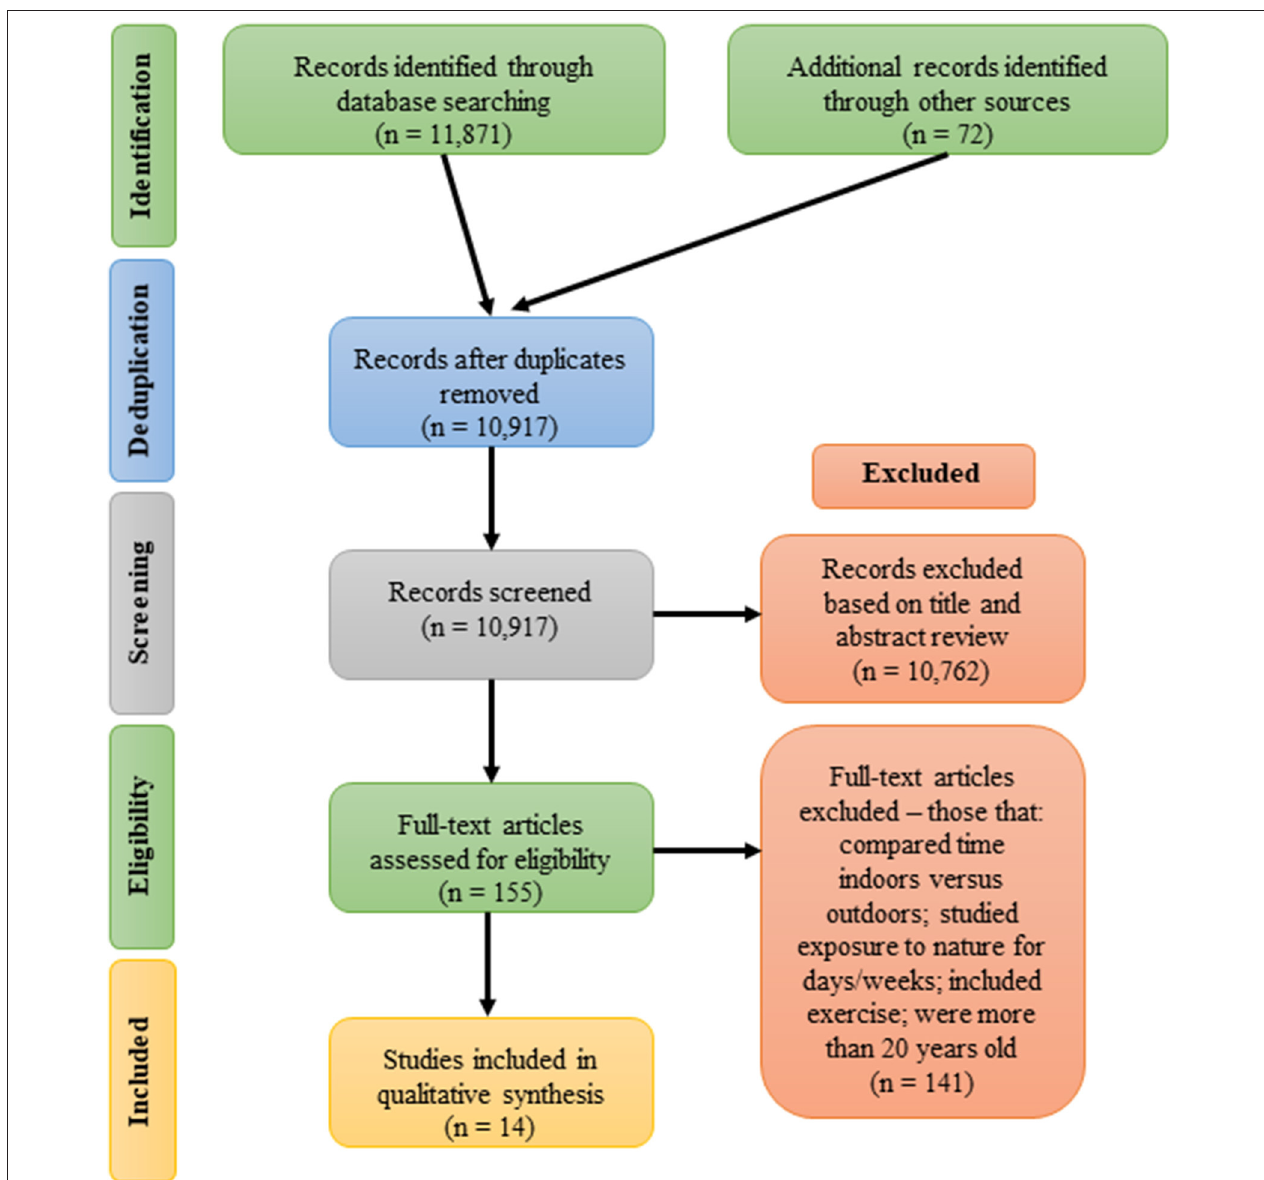
FIGURE 1 | PRISMA flow